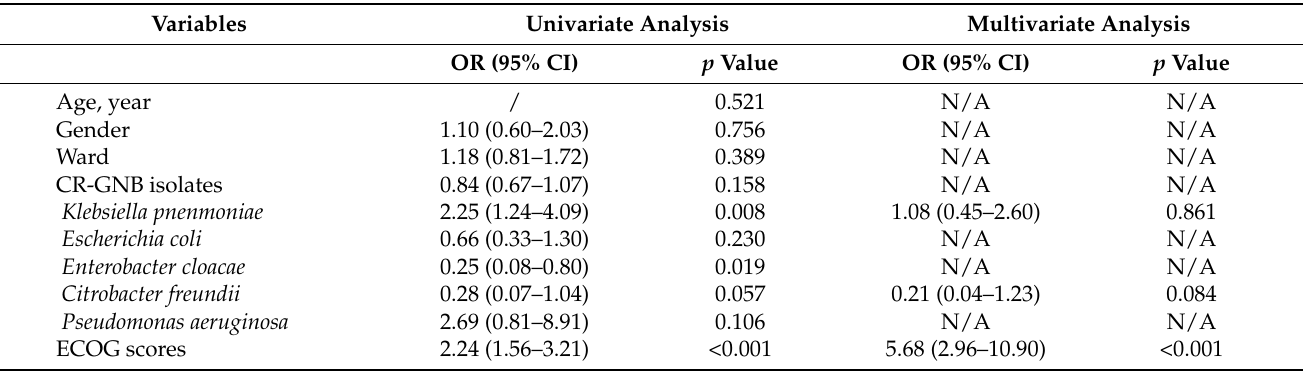
Table 2. Univariate and multivariate analysis of risk factors for secondary CR-GNB BSI in CR-GNB intestinal carrier patients in gastroenterology